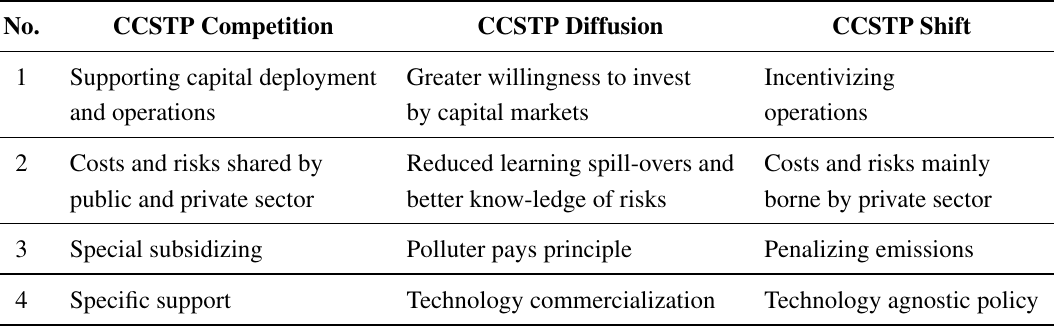
Table 5. CCSTP policy